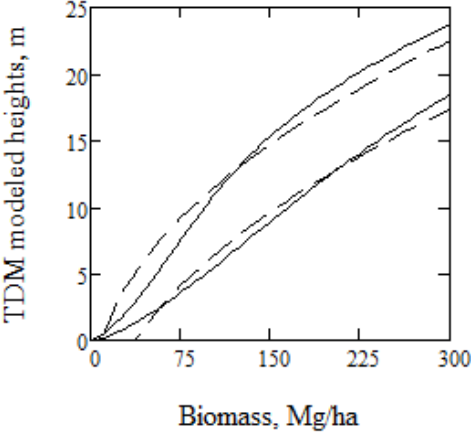
Figure 7. Range of model-based estimates of TDM heights versus biomass. The range is delimited by the curves (solid for IWCM, dashed for PD model) corresponding to the maximum and minimum of model estimated TDM heights versus